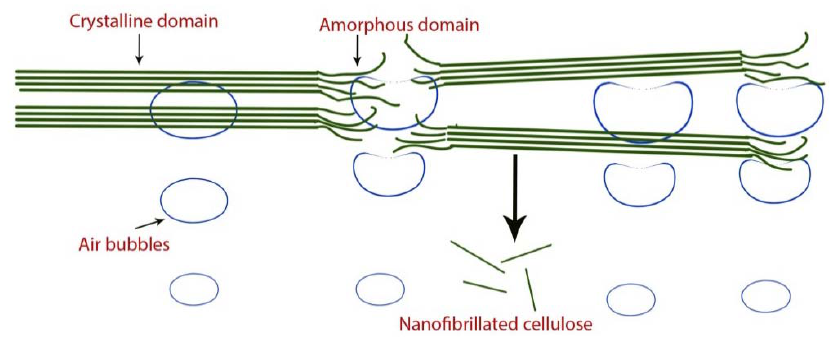
Figure 5. Sonification principle